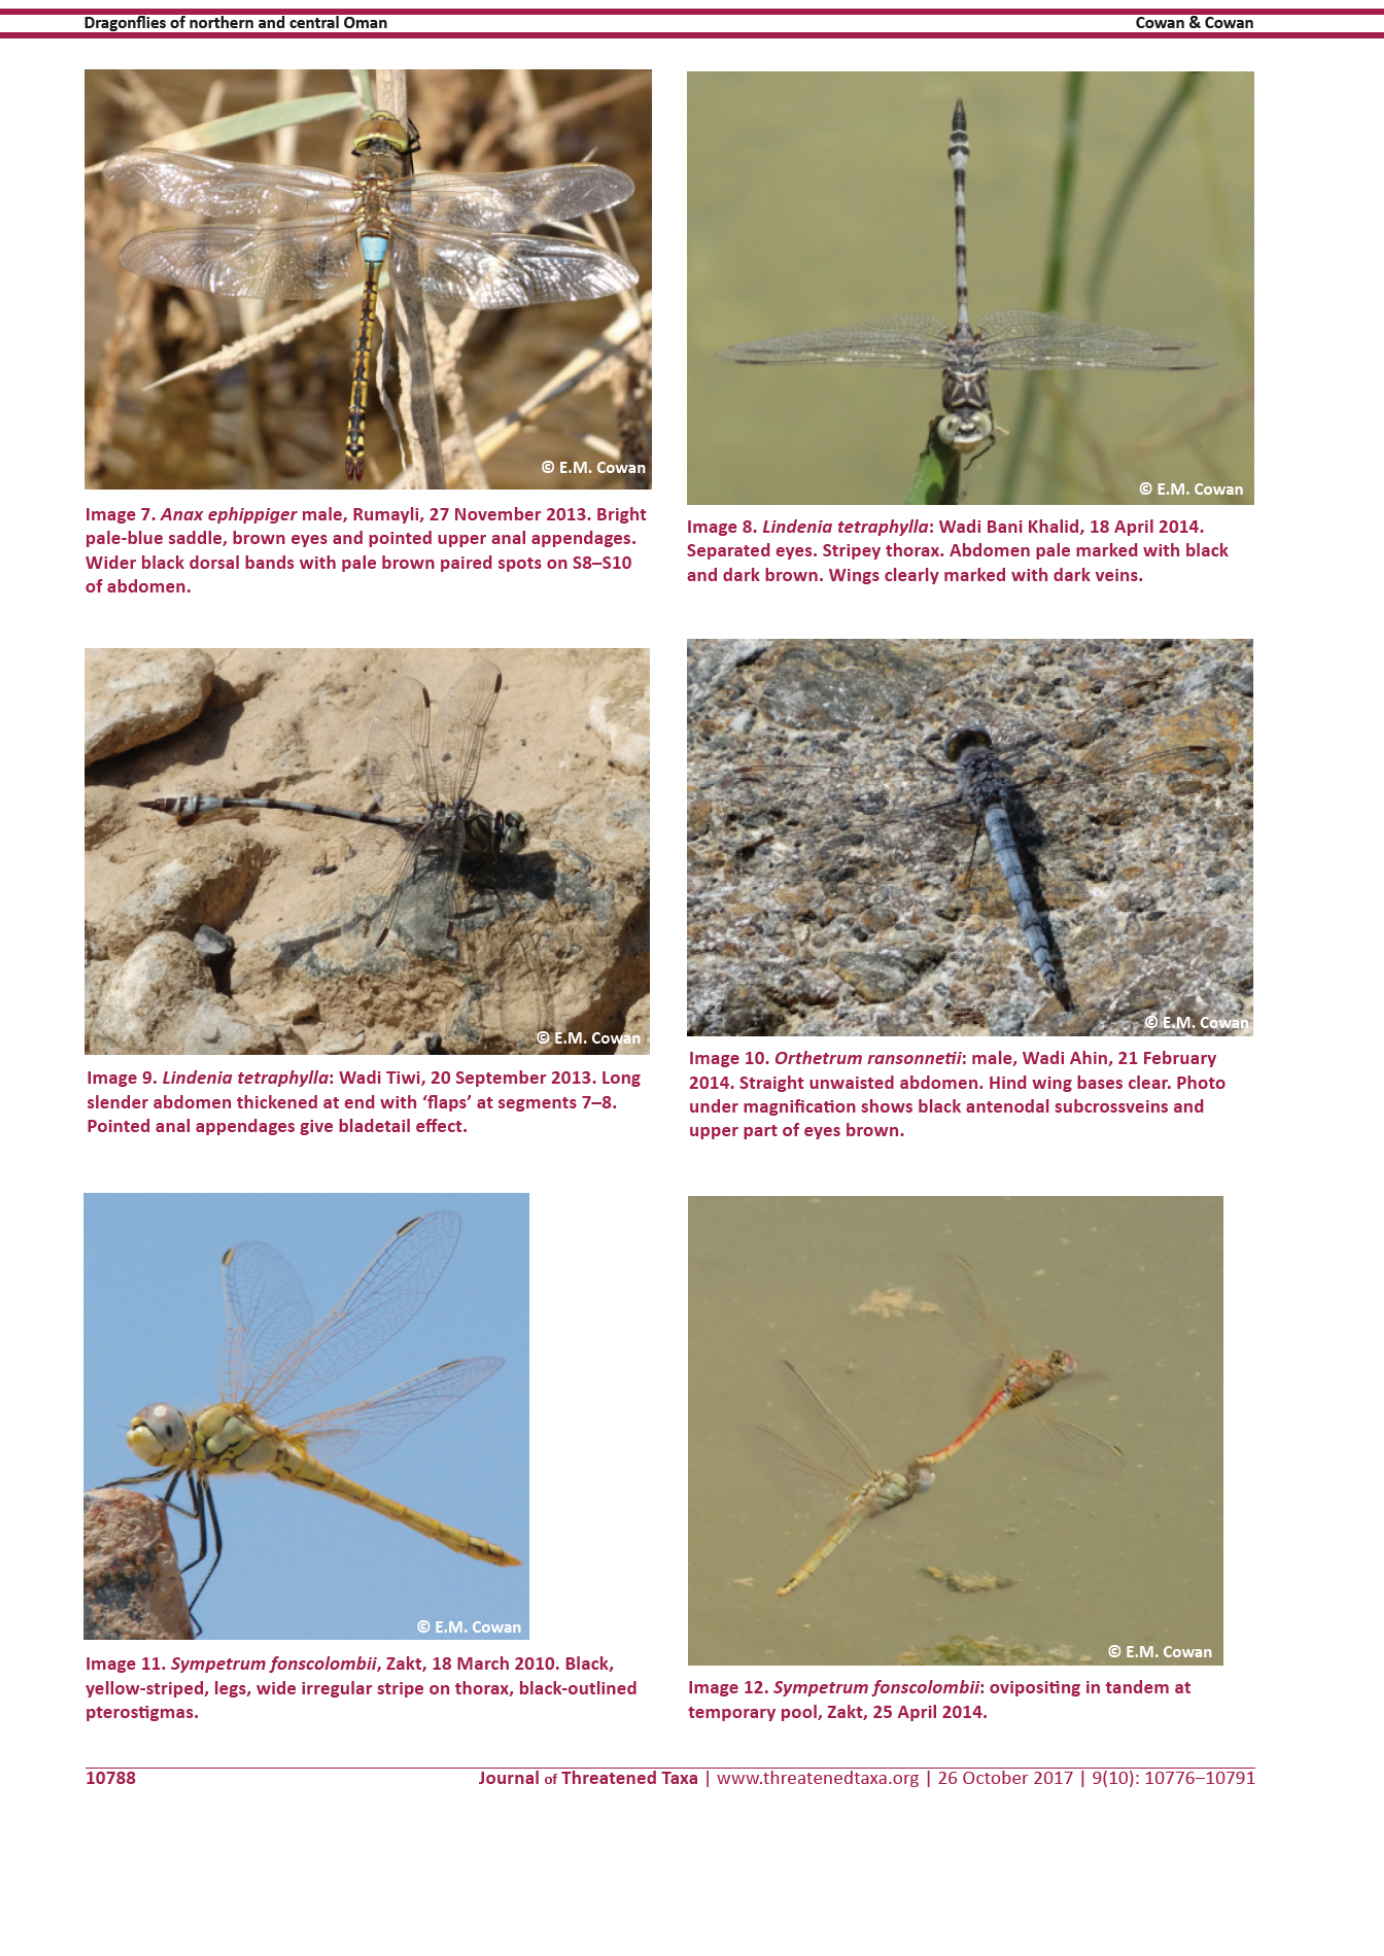
Image 11. Sympeftrum fonscoflombfifi, Zakft, 18 March 2010. Bflack, yeflflow-sftrfiped, flegs, wfide firreguflar sftrfipe on fthorax, bflack-ouftflfined pfterosfigmas.